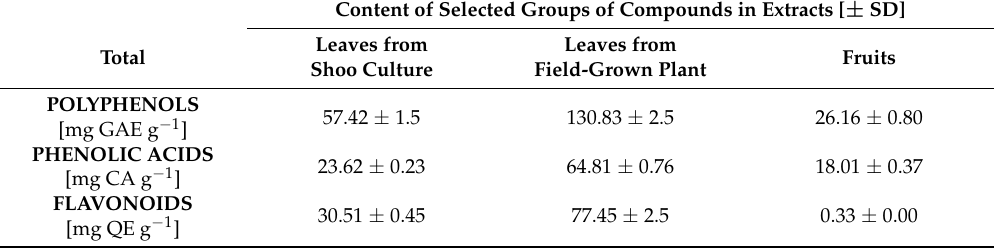
Table 4. Total polyphenols, phenolic acids, and flavonoids in ethanolic extracts from leaves of in vitro-propagated plantlets, field-grown plant, and fruits of Chaenomeles japonica . Content of Selected Groups of Compounds in Extracts [ ± SD] Leaves from Leaves from Fruits Total Shoo Culture Field-Grown Plant